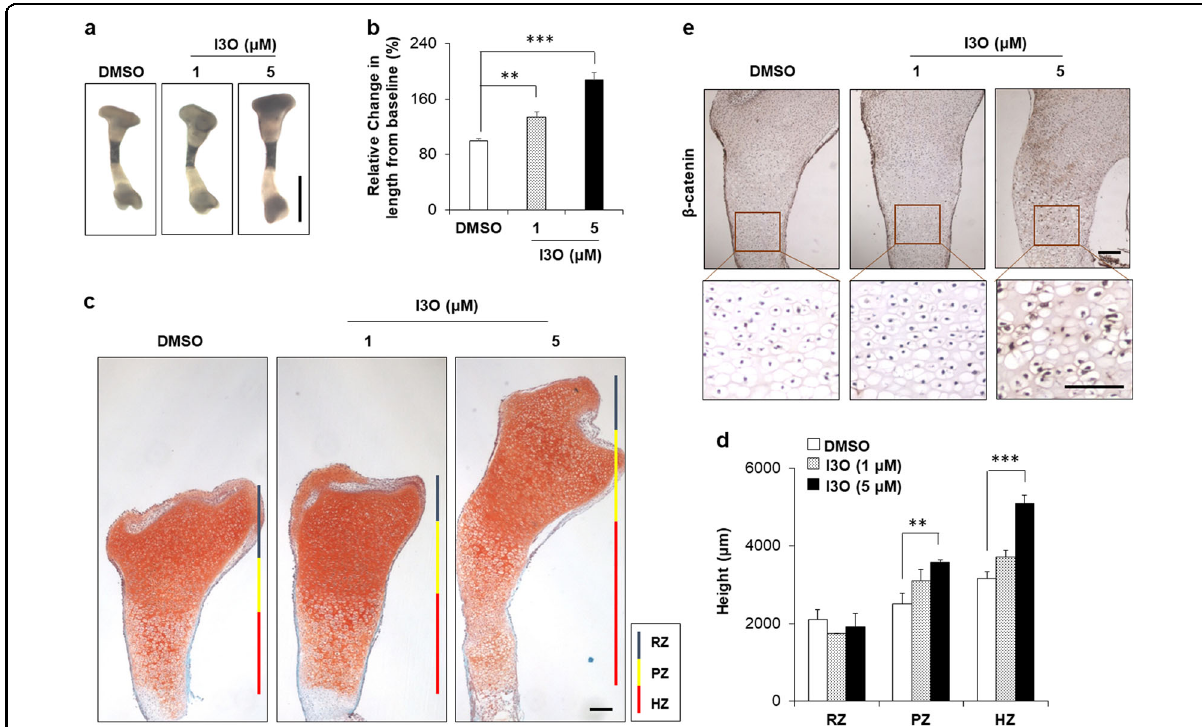
Fig. 2 The effects of I3O on the length of the ex vivo cultured tibia. a – e Ex vivo tibial cultures (E15.5) were treated with 0, 1, and 5 μ M of I3O for 6 days. Representative images of tibias after 6 days of culture are shown a . Scale bar, 1 mm. The relative lengths of tibias over 6 days of culture were quanti fi ed (mean ± s.e.m., n = 3 per group, ** P < 0.005 and *** P < 0.0005) b . Safranin O-stained paraf fi n sections of ex vivo cultured tibias were analyzed to compare the morphology and height of growth plate zones, including the resting zone (RZ), proliferating zone (PZ), and hypertrophic zone (HZ) c . Scale bar, 0.1 mm. d Each zone height in the growth plates of DMSO-treated and I3O-treated tibias was quanti fi ed (mean± s.e.m., n = 3 per group, ** P < 0.005 and *** P < 0.0005). Immunohistochemical staining for β -catenin in the growth plates of tibias e . Scale bars, 0.1